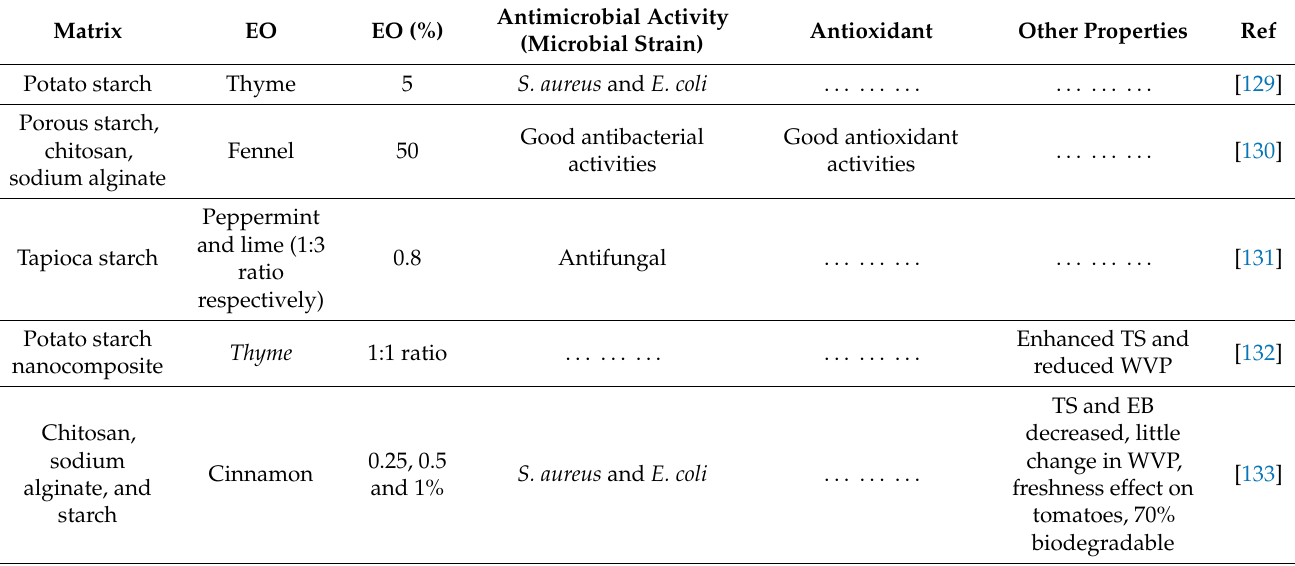
Table 3. Essential oils in starch-based